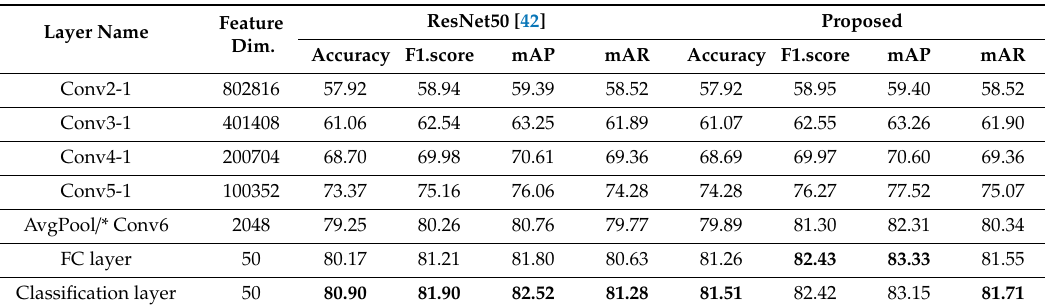
Table 7. Performance comparison of our proposed and the second-best model (Resnet50 [42]) on the basis of feature extraction from di ff erent layers (unit: %) (* in our modified layer, average pooling (AvgPool) is replaced by